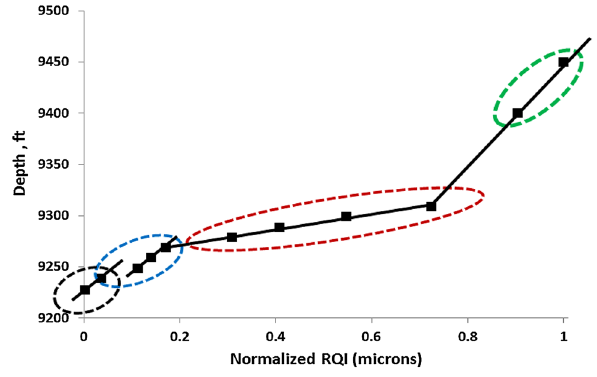
Fig. 13 Normalized cumulative reservoir quality index (RQI depth indicating four (4) possible zones